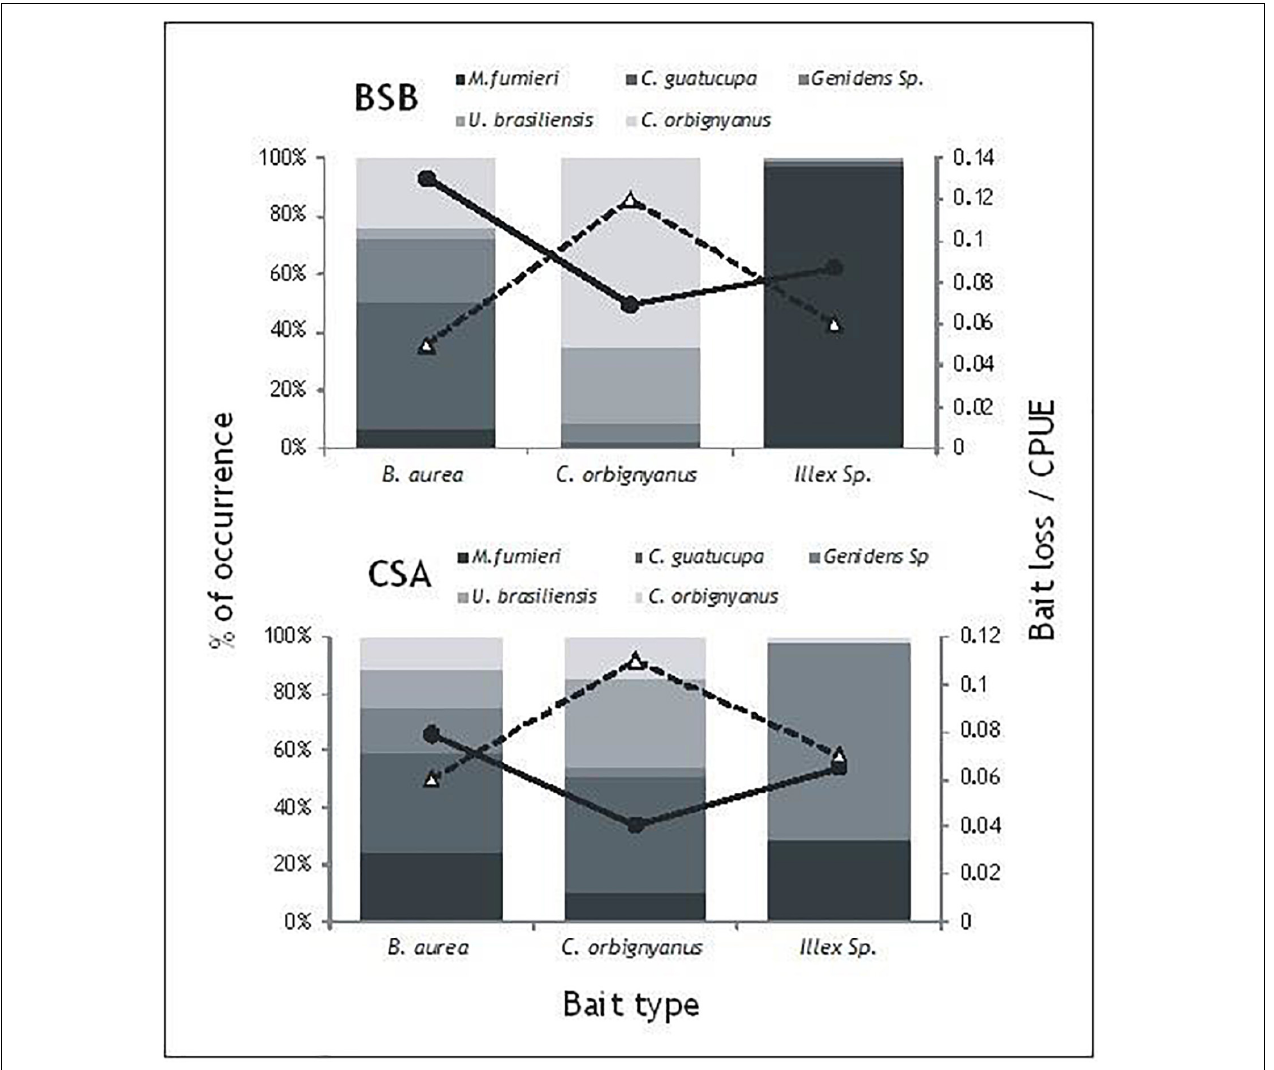
FIGURE 6 | Commercial fish catch in relation to bait type and bait loss with bottom longlines in BSB and CSA. CPUE (black circle, full line), Bait loss rate (white triangle, dotted